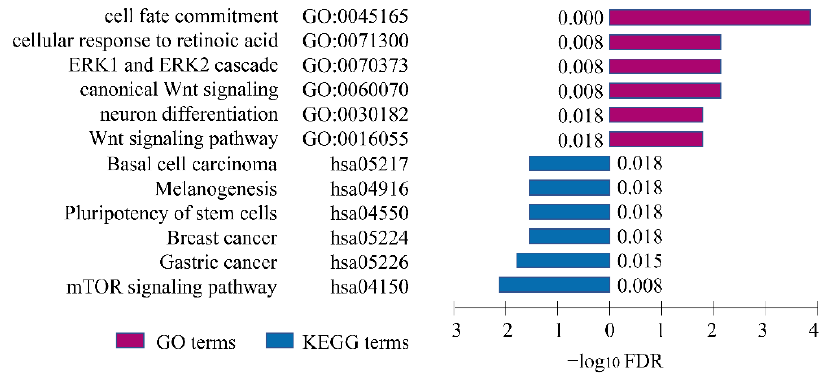
Figure 3. Pathway enrichment analyses. GO and KEGG pathway enrichment analyses for genes regulated by NSCL/P risk SNPs. Purple columns represent GO terms and blue columns represent KEGG terms.